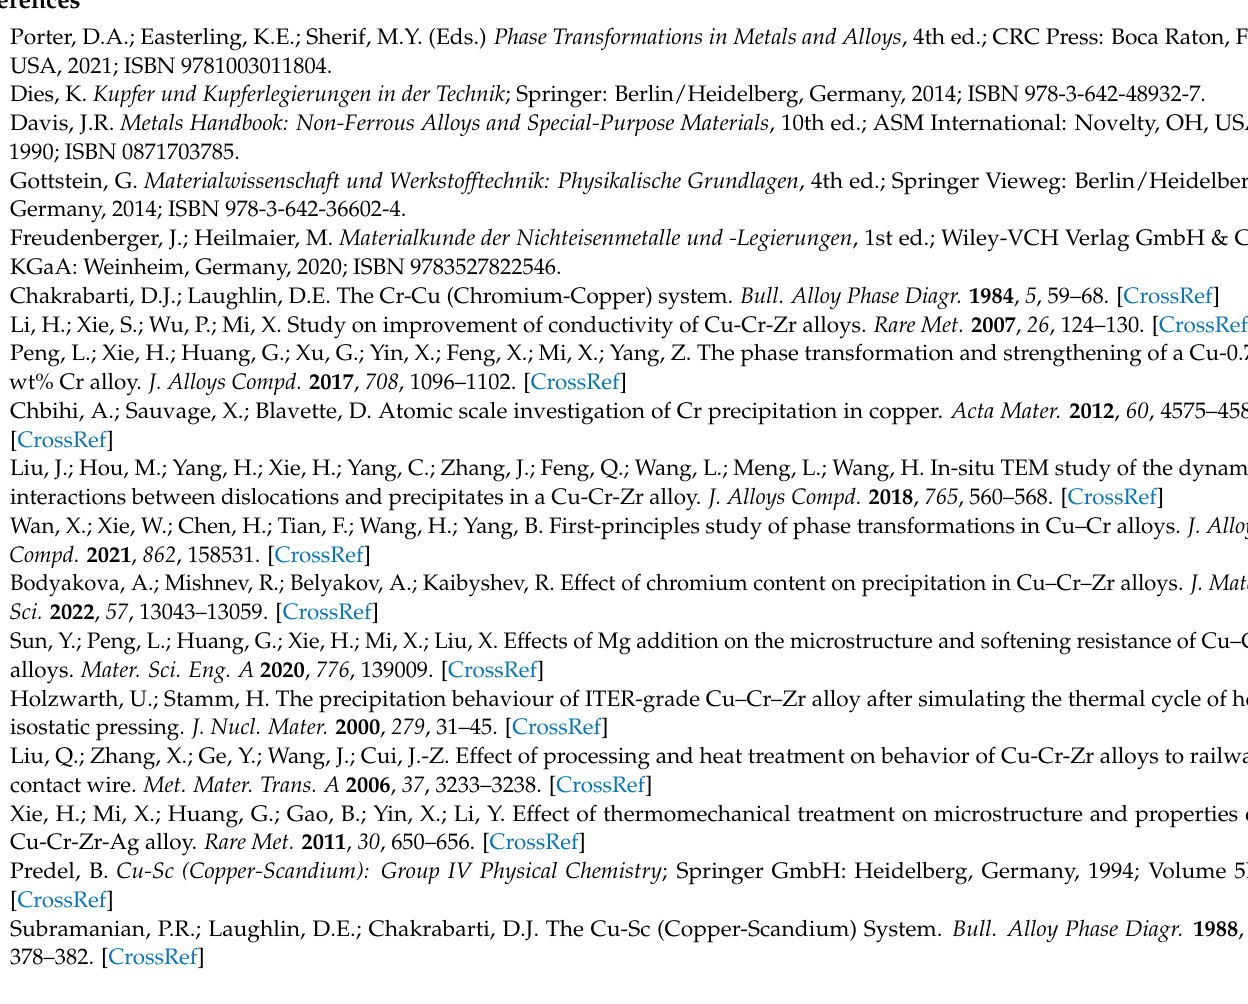
( a ) ( b ) ( c ) Figure A14. Microstructure evolution of Cu-OFE during DSC measurements in the optical microscope: ( a ) initial state after 75% cold rolling; and after DSC measurement; ( b ) condition 1; ( c ) condition 2.